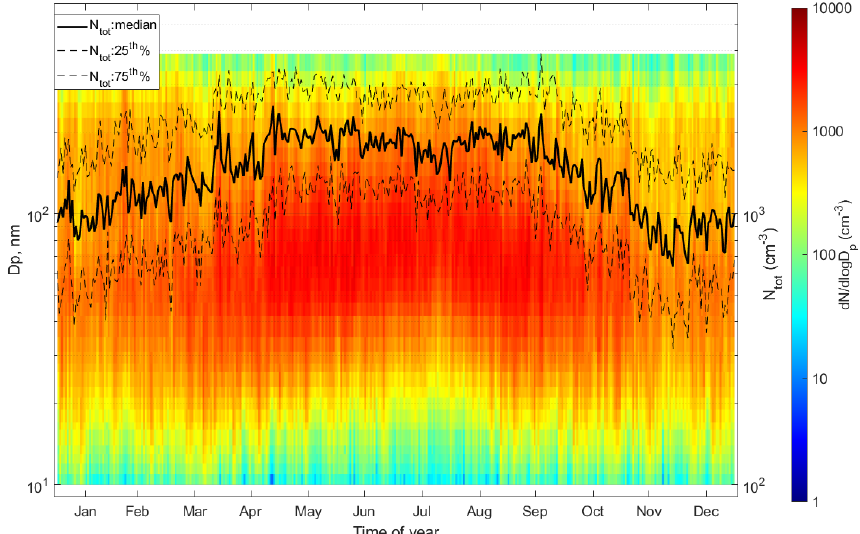
Figure 1. Seasonal variation in the aerosol number size distribution between 10 and 390nm presented as daily median aerosol number size distribution for the whole study period, 2000–2017. Superimposed on the surface plot are the median and quartile ranges of integral number concentration.